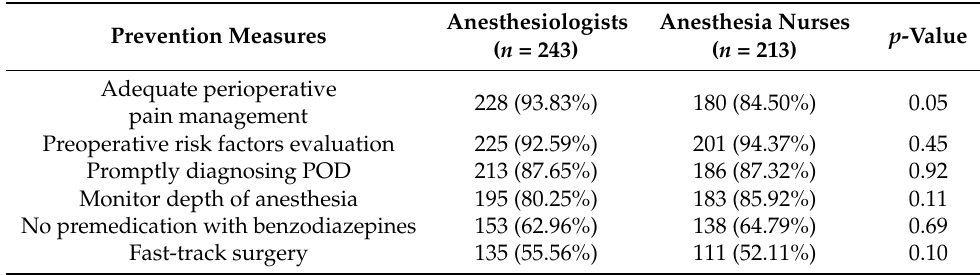
Table 3. Reported prevention measures for emergence